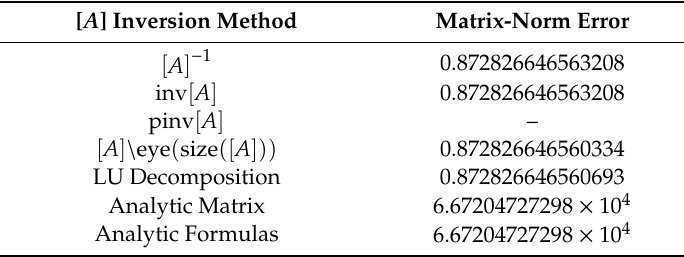
Table1. Matrix2-normerrordefinedasthedi ff erencebetweeneachcaseandthebaselineMoore–Penrose matrix pseudoinversion, pinv . Skew angle was set to β i = { 90 90 90 } T during a 30 degree maneuver, while gimbal angles δ i = { δ 1 δ 2 δ 3 } T were free to